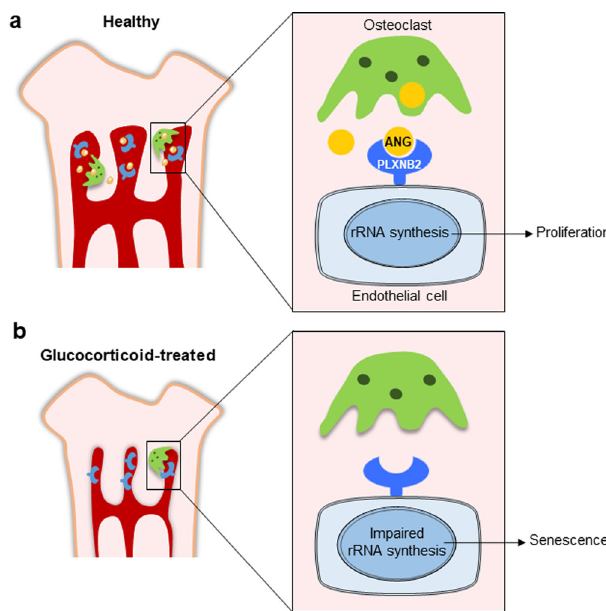
Fig. 9 Schematic model for the ANG/PLXNB2-rRNA transcription signaling in mediating osteoclast-endothelial cell crosstalk in metaphysis of growing bone. a In normal growing mice, ANG secreted from metaphyseal osteoclasts maintains the proliferation of neighboring blood vessel endothelial cells in long bone through ANG/PLXNB2-rRNA transcription signaling. b GC treatment inhibits ANG production through suppression of osteoclast formation in metaphysis, leading to blood vessel cell senescence and impairment of angiogenesis with coupled